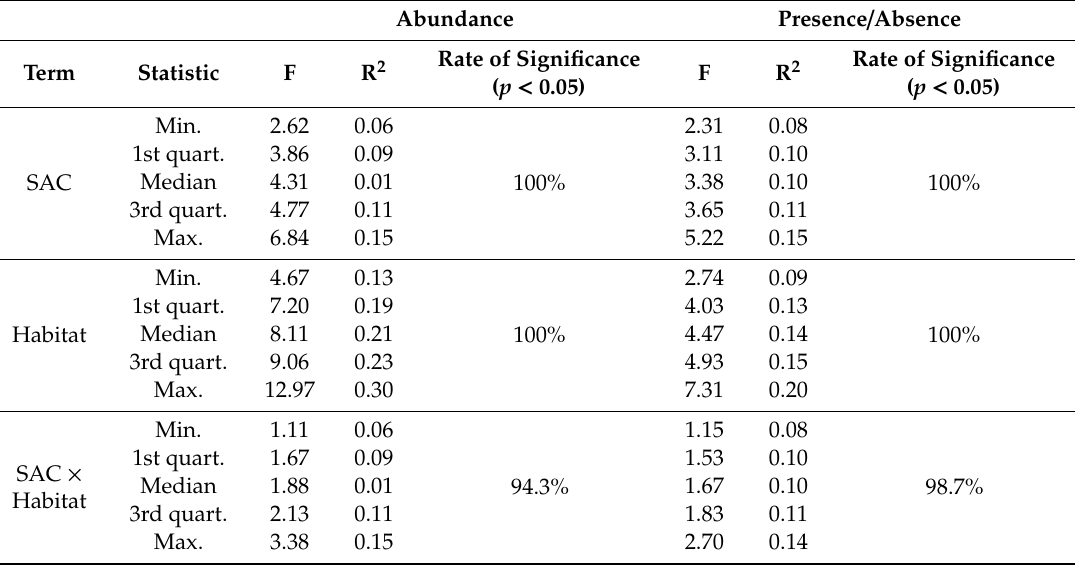
Figure 5. Profile of overall diversity across habitats based on Jaccard dissimilarity (left) and Bray– Curtis dissimilarity (right). Table 5. Summary statistics of PERMANOVA results derived from 999 random resampling of the original dataset based on the plot numbers given by the decay of MultSE both using abundance and presence / absence